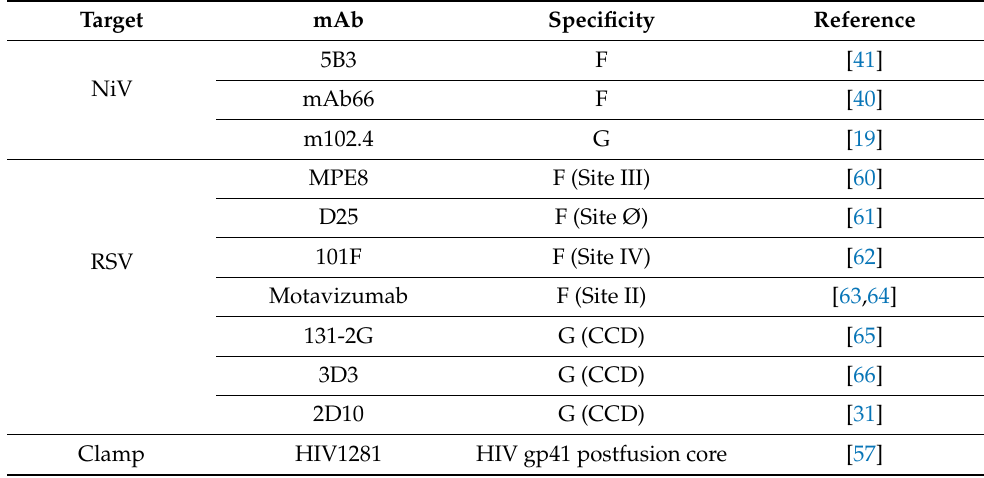
Table 1. Summary of mAbs used in this study for antigen characterisation. All mAbs are made